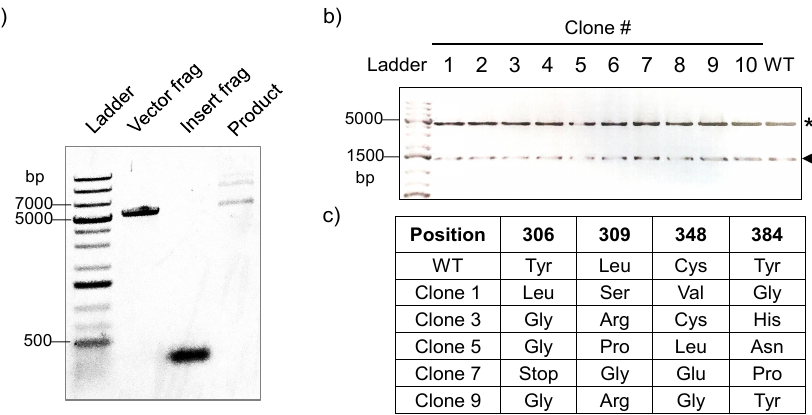
Figure 1. Construction of the PylRS library using Gibson assembly. ( a ) Agarose gel electrophoresis of the DNA fragments and the assembled product mixture. ( b ) Agarose gel electrophoresis of 10 clones randomly picked from a Luria – Bertani (LB)-agar plate containing 34 µg/mL chloramphenicol. The plasmids were digested with the restriction enzymes Sal I and Spe I at 37 °C for 2 h prior to electrophoresis. The asterisk indicates the vector fragment, while the arrow indicates the PylRS insert. ( c ) DNA sequencing results of five PylRS plasmids, showing the amino acid identities at the randomized positions.